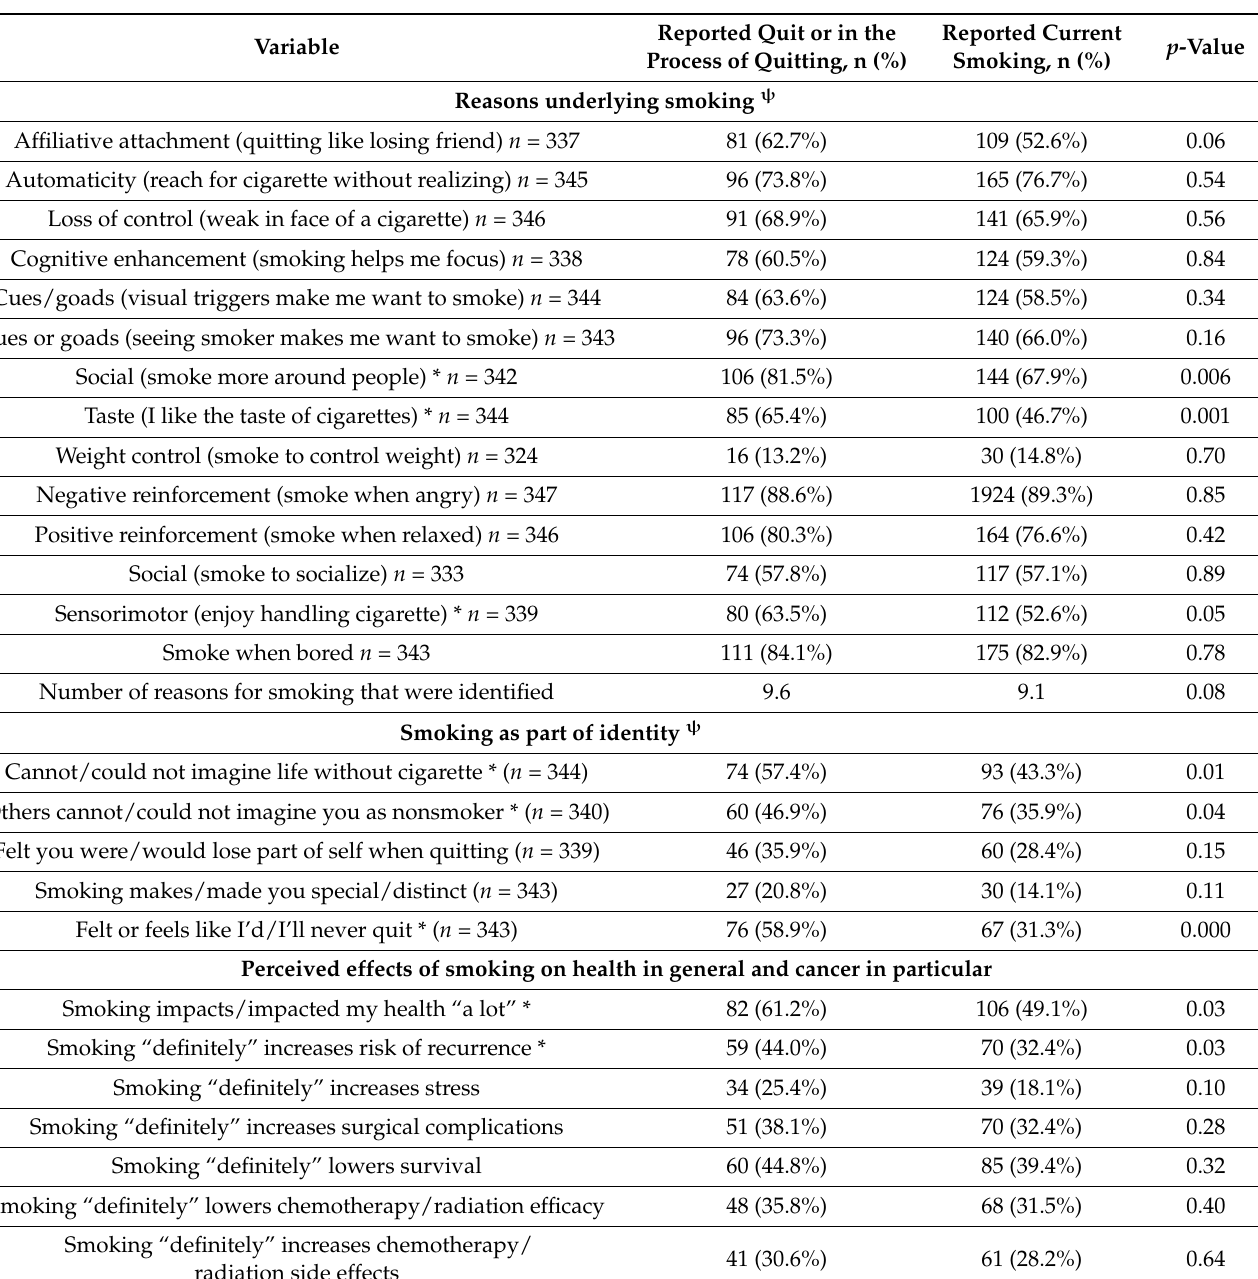
Table 2. Perceptions related to tobacco use among a sample of Jordanian cancer patients who currently smoke or smoked up to diagnosis and then quit (column totals